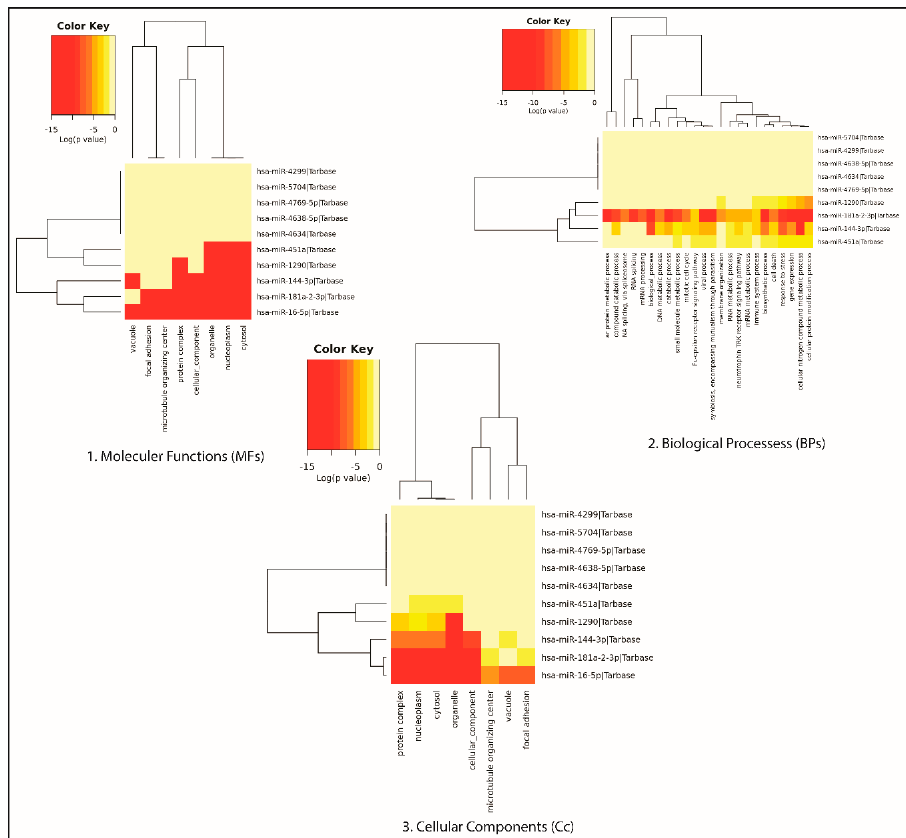
Figure 4. Gene Ontology of the 10 candidate sepsis DEM biomarkers. Representation of functional enrichment of miRs showing ( 1 ) miRs versus Molecular Functions, ( 2 ) miRs versus Biological Processes, and ( 3 ) miRs versus Cellular components, which were retrieved from the DIANA mirPath V3.0 database.